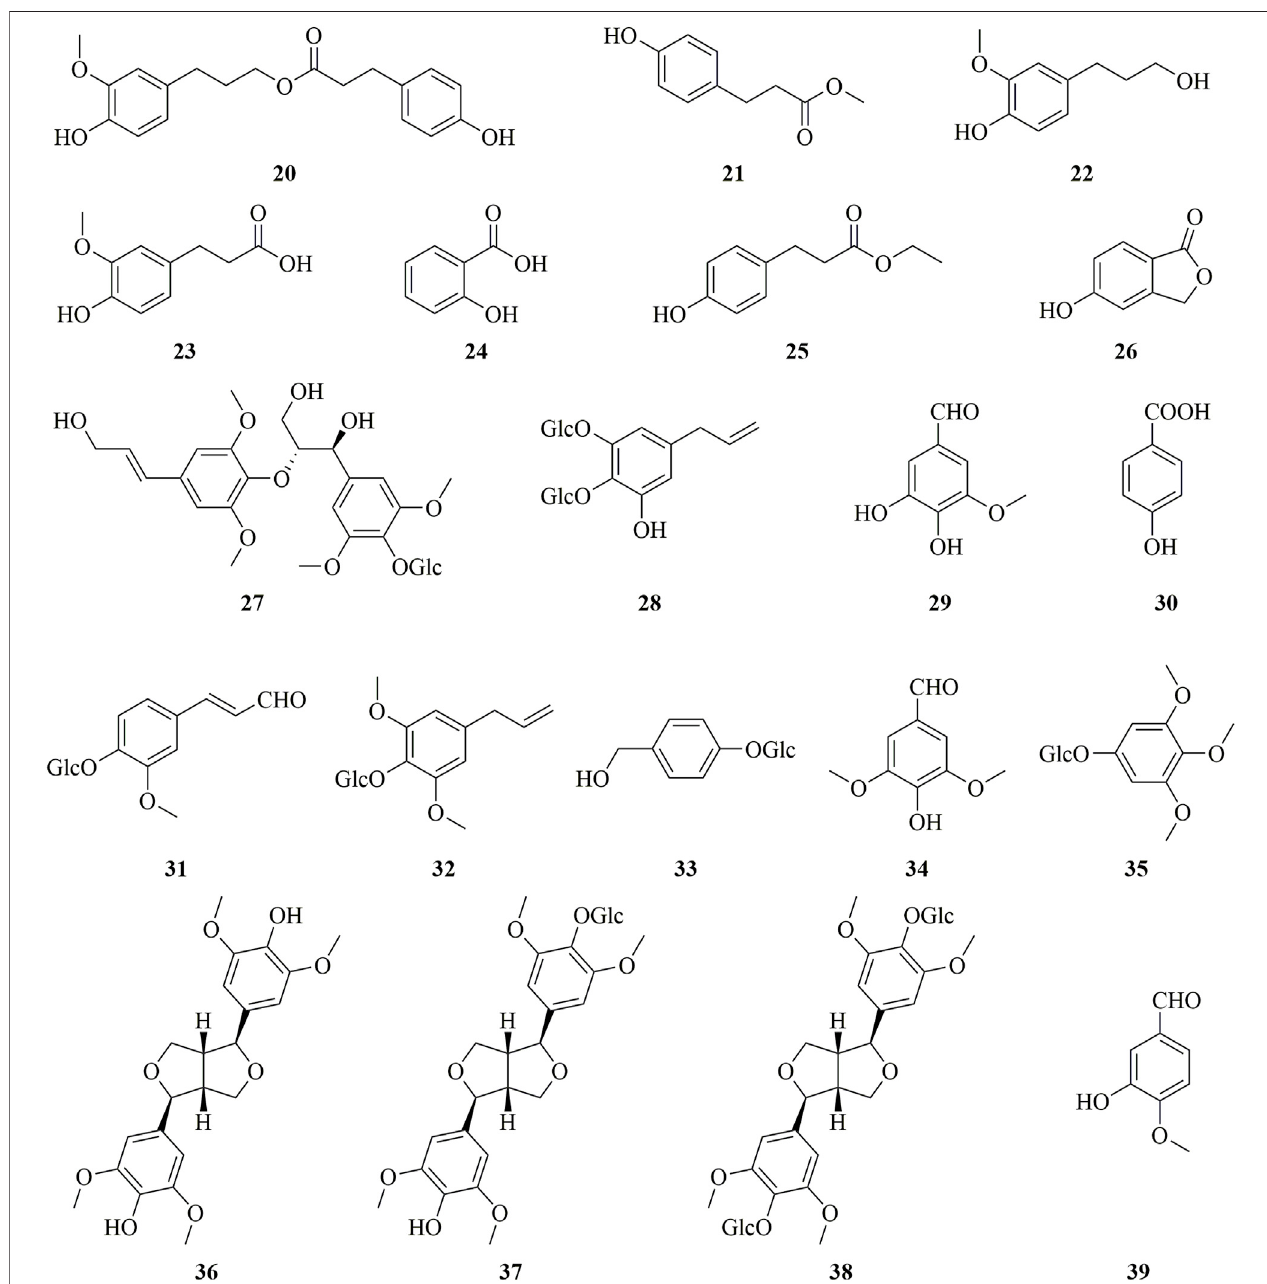
FIGURE 6 | Structure of phenols ( 20 – 39 ) in D. huoshanense